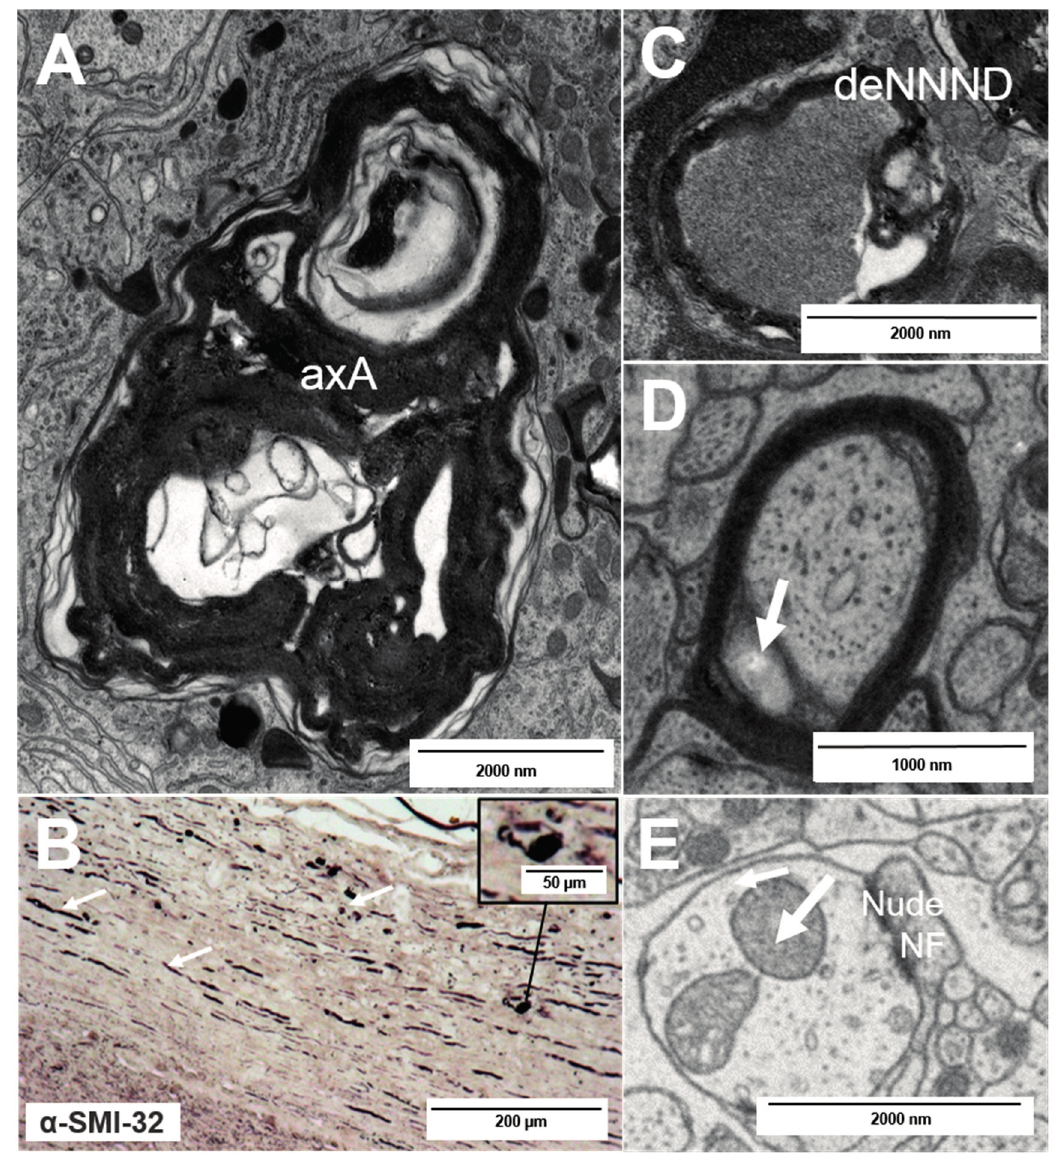
Figure 4. Types of nerve fiber pathology: ( A ) axolytic axons (axA); ( B ) axonal transection as observed after staining for hypophosphorylated neurofilaments (arrows) with typical “ovoid” formation (inset); and ( C – E ) fine and early nerve fiber pathology: a decrease in the nearest neighbor neurofilament distance ( C , deNNND), enlargement of the inner tongue ( D , arrow) and a nude nerve fiber (nudeNF) with enlarged mitochondria ( E ,